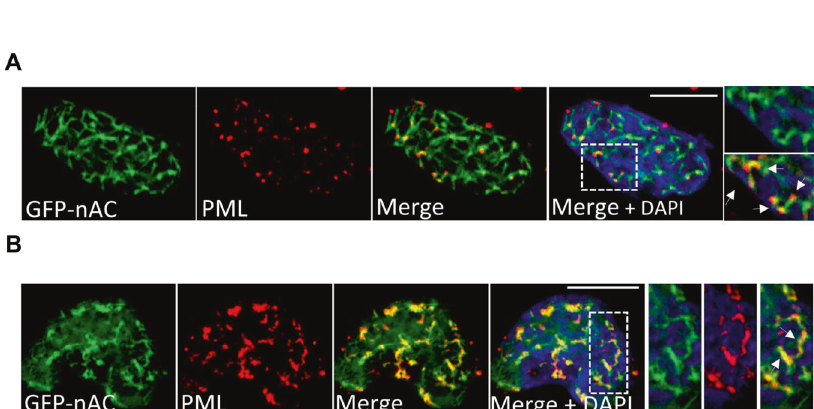
Fig. 1 DNA damage causes the formation of nuclear actin fi laments that associate with γ H2AX and are required for an ef fi cient DDR. A Immuno fl uorescence (IF) showing nuclear actin structures (green) was observed in U2OS cells expressing GFP-nAC (U2OS + GFP-nAC). DNA is stained with DAPI (blue), scale bar is 10 µm. B IF showing the association between γ H2AX (red) and nuclear F-actin (green) in U2OS cells expressing GFP-nAC and treated with 1 mM etoposide for 3 h (colocalisation indicated by white arrows). DNA is stained with DAPI (blue), scale bar is 10 µm. C 3D image is taken from confocal IF analysis of nuclear F-actin (green) and γ H2AX (magenta) in a U2OS cell expressing GFP-nAC that were fi xed 1 h post irradiation with 50 J/m 2 UV. D Quanti fi cation of IF comparing nuclear F-actin accrual in U2OS + GFP-nAC cells treated with etoposide (1 mM for 3 h), hydrogen peroxide (H 2 O 2 ) (200 µM for 2 h, Neocarzinostatin (NCS) (0.8 µg / ml for 2 h), ultra-violet (UV) irradiation ( fi xed 1 h after 50 J/m 2 irradiation) or serum-starved. Data were taken from three independent experiments ( n > 100 cells). E Representative Western blot (WB) from a nuclear fractionation of U2OS + GFP-nAC cells expressing EGFP (control) or mCherry-EXP6. C cytoplasmic fraction and N nuclear fraction. F Example WB from DNA damage time-course assay. U2OS cells expressing either EGFP (control) or EXP6 were treated with 10 µM BrdU for 24 h and then irradiated with 50 J/m 2 UV. Cells were harvested at various time points and γ H2AX was quanti fi ed. β -actin was used as a loading control. G Quanti fi cation of DNA damage time-course assay showing fold change of γ H2AX normalised to the highest intensity for each treatment (orange data points). H Cell vitality assay comparing cell health of U2OS cells expressing EGFP (controls) or mCherry-EXP6 (EXP6) and treated with or without 1 mM etoposide for 3 h. Healthy cells are present in the bottom right quadrant, the red arrow shows cells with reduced vitality. I Quanti fi cation of cell vitality assays shown in H ( n = 8). Data were presented as mean ± SEM and were analysed by one-way ANOVA and Tukey ’ s test. * p < 0.05, ** p < 0.01 and *** p < 0.001. ns not signi fi cantly